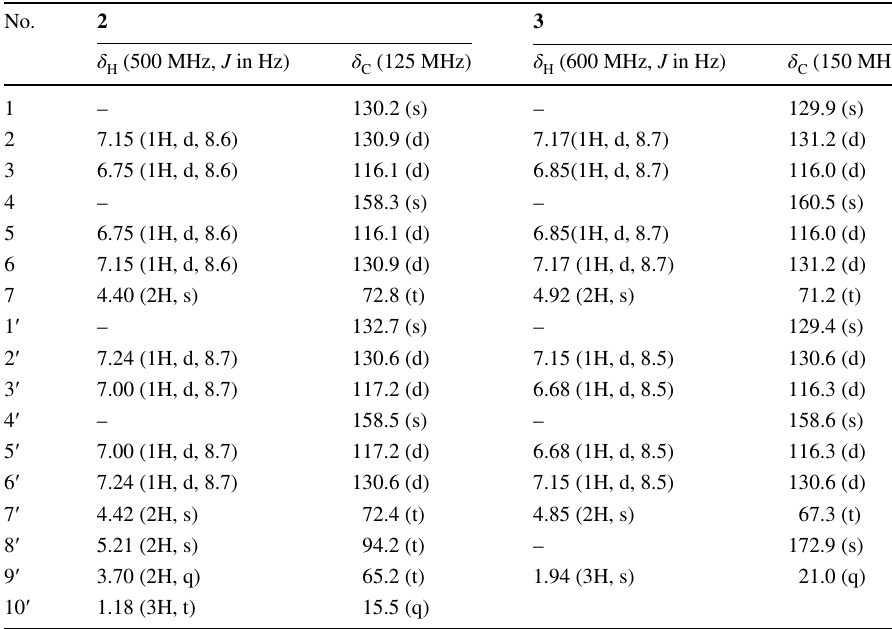
Table 2 1 H-NMR and 13 C- NMR data of compounds 2 and 3 in CD 3